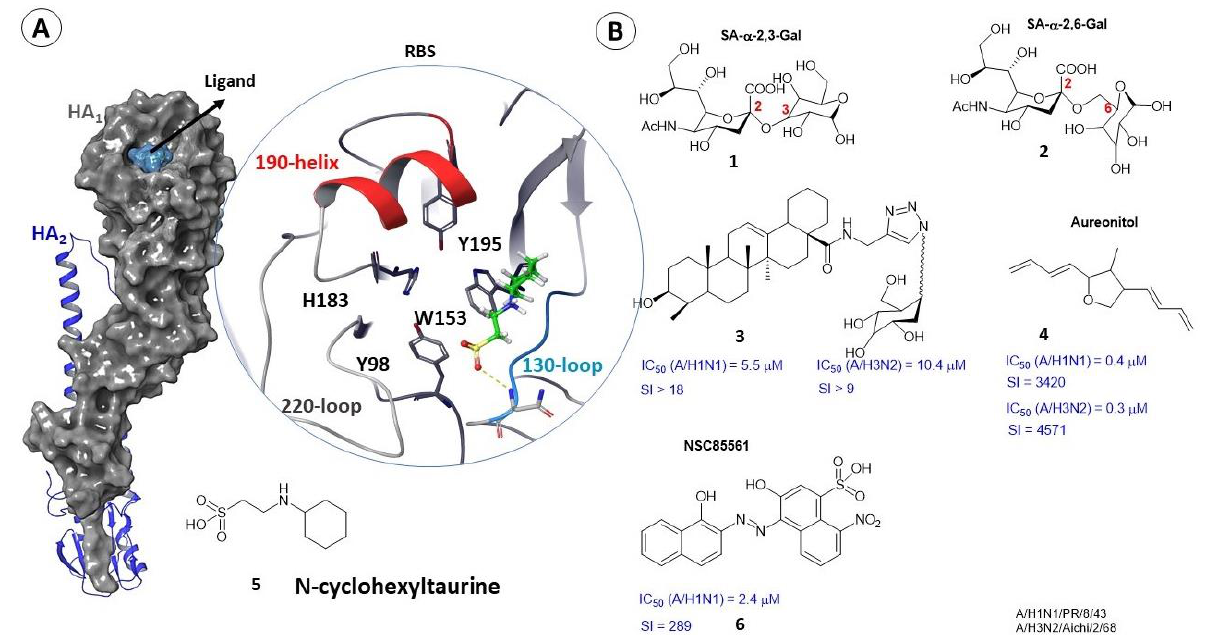
Figure 4. Protomer of HA. The location of N -cyclohexyltaurin 5 ( A ) (adapted from [25]) in the re- ceptor-binding site. Inhibitors of RBS ( B ). SI — selectivity index. receptor-binding site. Inhibitors of RBS ( B ). SI—selectivity